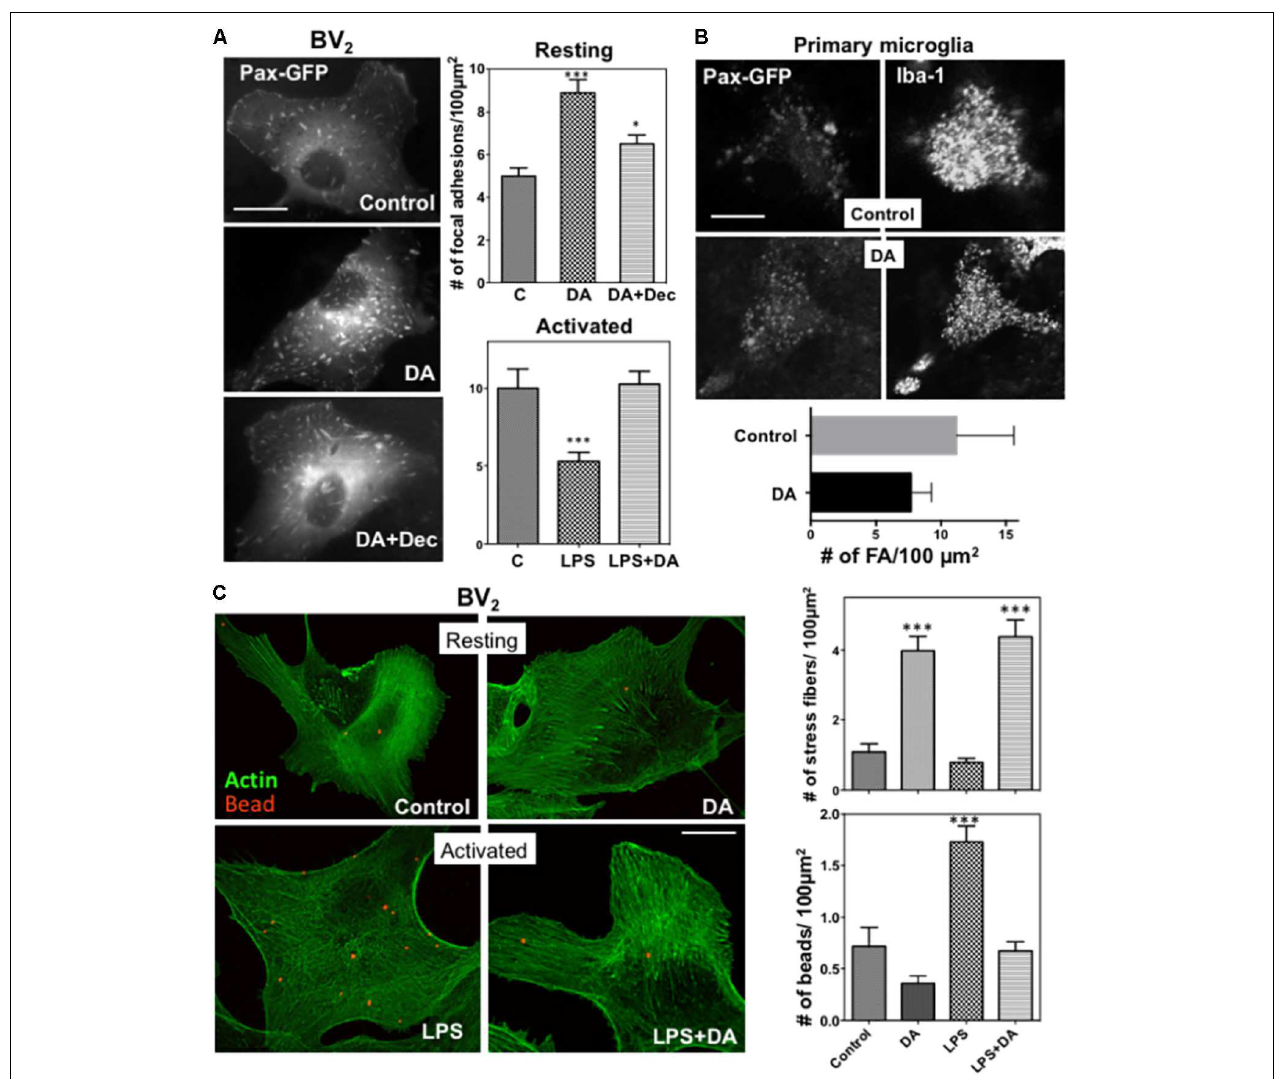
FIGURE 3 | (A) Changes in focal adhesions in response to DA. BV 2 cells were transfected with paxillin-GFP, and focal adhesions were imaged using fluorescence microscopy. The number of focal adhesions in resting cells was significantly increased in response to DA, which can be blocked by decynium (ANOVA: ∗∗∗ P < 0.005 compared to control; ∗ P < 0.05 compared to DA). Values are means ± standard error of 10–15 cells. Scale bar = 10 µ m. (B) Primary astroglia mixture cultures were transfected with paxillin-GFP. Microglia cells were identified with Iba-1 staining and focal adhesions, visualized with paxillin-GFP, were imaged using